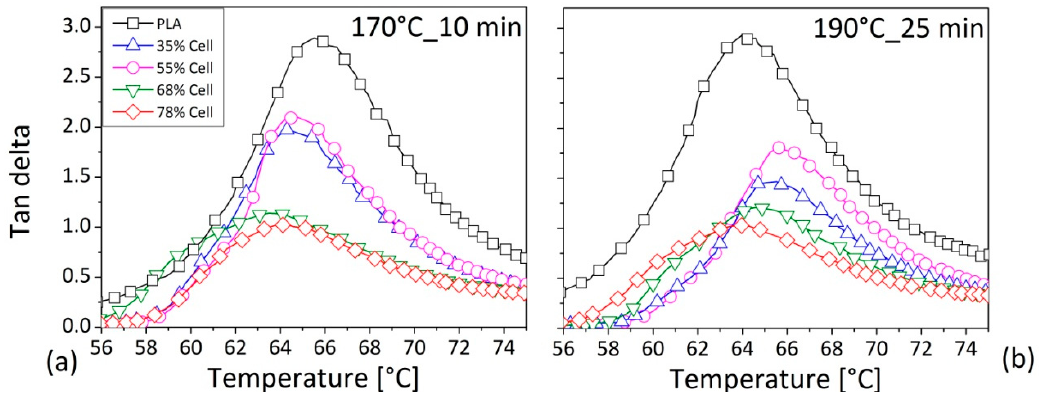
Figure 11. Damping factor as a function of the temperature at 1 Hz for the PLA compounds prepared: ( a ) at 170 °C for 10 min, ( b ) at 190 °C for 25 min. Legend in Figure 11B as in Figure 11a. Table 5. Temperature in correspondence to the maximum of the tan delta curves for the PLA compounds.